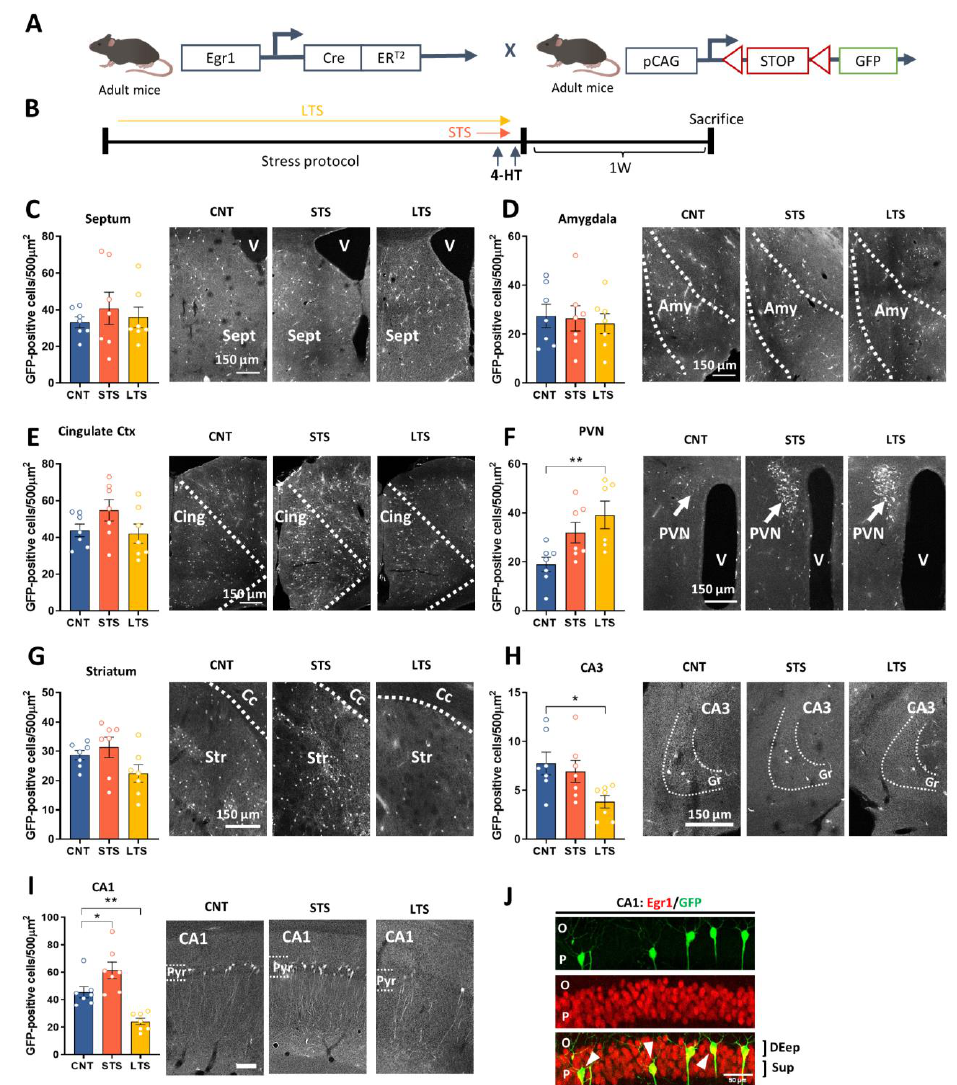
Figure 1. Egr1-dependent activated neuronal ensembles in different brain regions by chronic stress. ( A ), Schematic representation of double-heterozygous-mutant Egr1-CreERT2 × R26RCE GFP mice. ( B ), Egr1-CreERT2 × R26RCE mice were subjected to 0 (CNT), 2 (STS) or 28 (LTS) days of CUMS. For the last two days of the protocol, all mice received 50 mg/kg of 4-hydroxytamoxifen (4-HT, i.p), and one week later they were sacrificed. Representative images and quantification of Egr1-dependent activated cells (estimated number of GFP-positive cells/area of 500 µ m 2 ) per region in: the septum ( C ), one-way ANOVA group effect: F (2,18) = 0.3858, p = 0.6854; the amygdala ( D ), group effect: F (2,18) = 0.1160, p = 0.8911; the cingulate cortex ( E ), group effect: F (2,18) = 1.946, p = 0.1718; the paraventricular nucleus (PVN) ( F ), group effect: F (2,17) = 5.686, p = 0.0129; the striatum ( G ), group effect: F (2,18) = 2.716, p = 0.0931; the CA3 ( H ), group effect: F (2,18) = 4.322, p = 0.0293, and the CA1 ( I ), group effect: F (2,18) = 17.63, p < 0.0001; Scale bar, 50 µ m. The values are expressed as the mean ± SEM, N = 7 adult mice per condition. Dunnet’s post hoc test, * p < 0.05, ** p < 0.005 compared with CNT. ( J ) Representative images of the CA1 of the hippocampus show- ing GFP-activated cells (green) and Egr1-positive cells (red). White arrows indicate double-Egr1-positive and GFP-positive cells. V, ventricle; CC, corpus callosum; O, Stratum oriens; P, Stratum